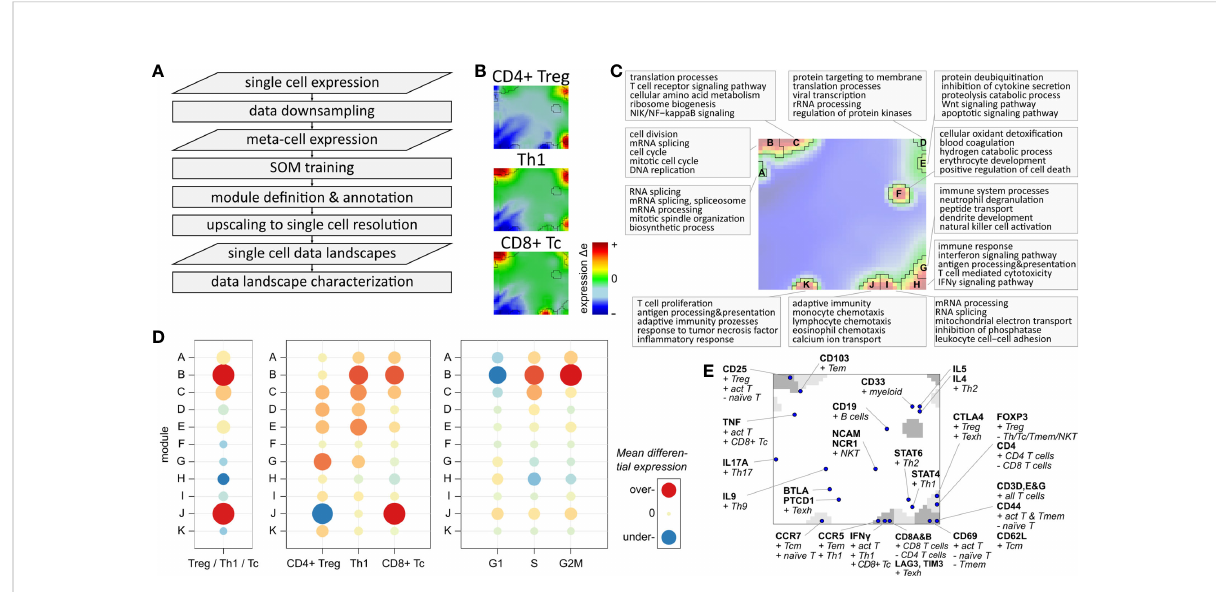
FIGURE 3 Expression landscape of T cells: (A) Flow chart of single-cell data portraying work fl ow (see Supplementary Figure S5 for more details). (B) Expression portraits of most abundant subpopulations. Red and blue pixels represent meta-genes over- and under-expressed in the respective subpopulation, respectively, meta-genes colored in green show no differential expression. (C) Module de fi nition and functional annotation. (D) Mean module differential expression averaged over all cells in the three main subpopulations, and grouped by subpopulation and by cell cycle phase, respectively. (E) Mapping of T cell and immune cell subpopulation